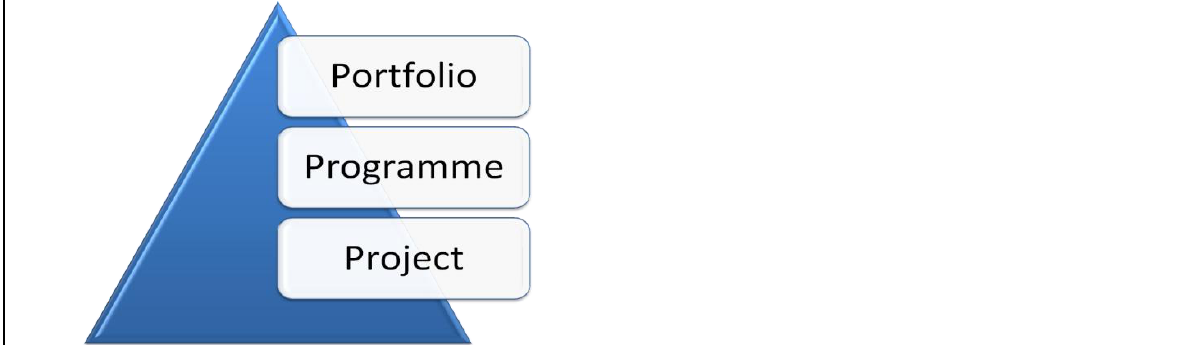
Figure 1. Three categories of organisational